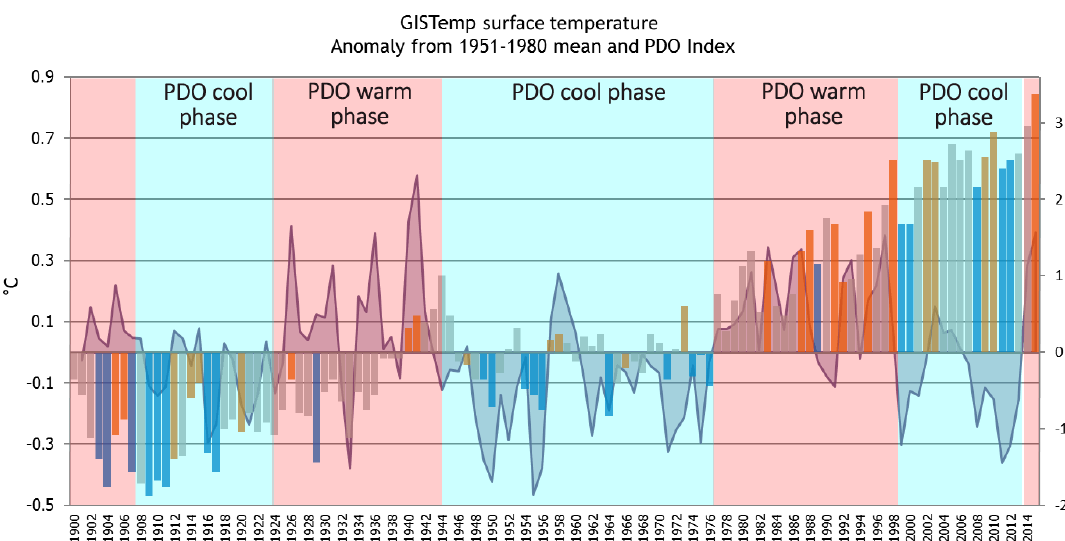
Figure 1. Global mean surface temperature anomaly from the 1951 to 1980 mean (GISTemp; peak of the annual bars; left scale) with La Niña years (blue bars), El Niño years (orange-brown bars), neutral years (grey bars) and the PDO index (solid line; right scale), with PDO phases marked (compiled by Miriam O’Brien for 1900 to 2015). The data sources used GISS NASA (temperature), Australian Bureau of Meteorology (ENSO years based on the Southern Oscillation Index), Japan Meteorological Society (PDO index) and Trenberth 2015 (PDO